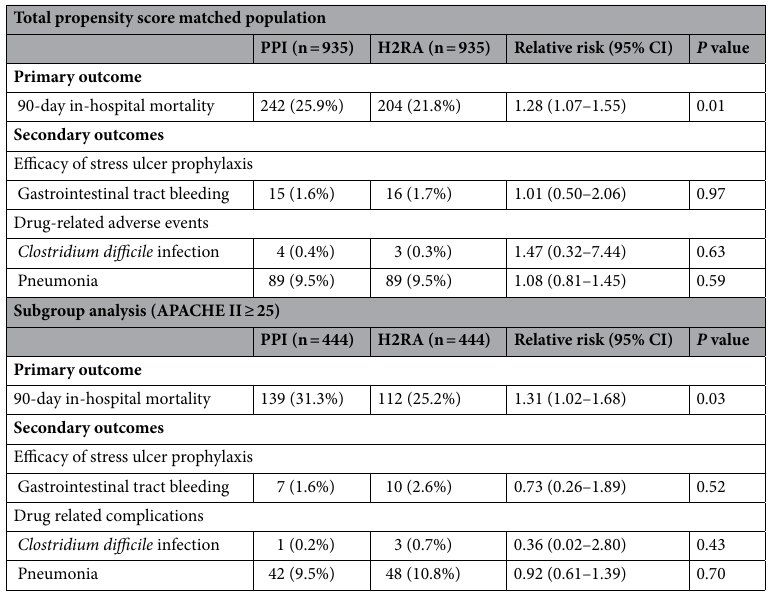
Table 2. Risk of primary and secondary outcomes. APACHE acute physiologic assessment and chronic health evaluation, CI confidence interval, H2RA histamine-2 receptor antagonist, PPI proton pump inhibitor.